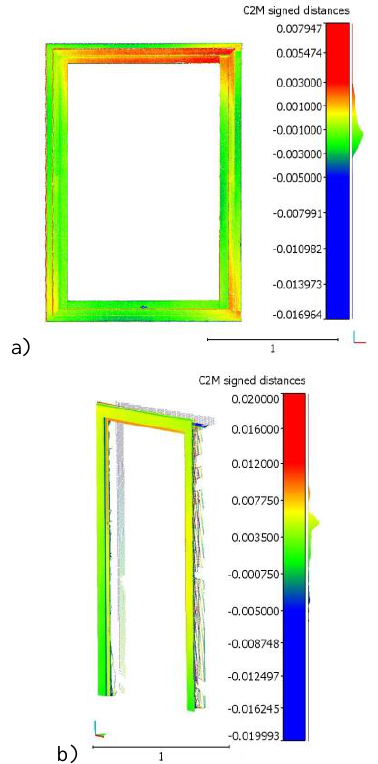
Figure 14. Colorized visualization of deformations (in mm) of the created meshes using cloud to mesh comparison (CloudCompare)